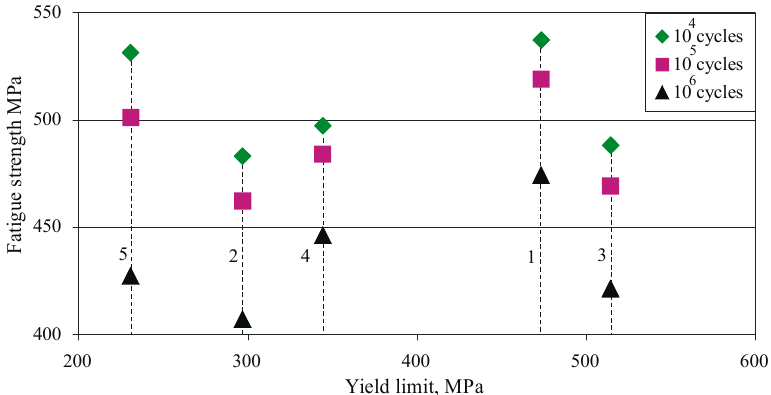
Figure 13. Dependence of fatigue strength on yield limit at different fatigue life: 1—as received, 2—annealed, 3—quenched, 4—quenched and tempered at 600 °C, 5—quenched and tempered at 300 °C.